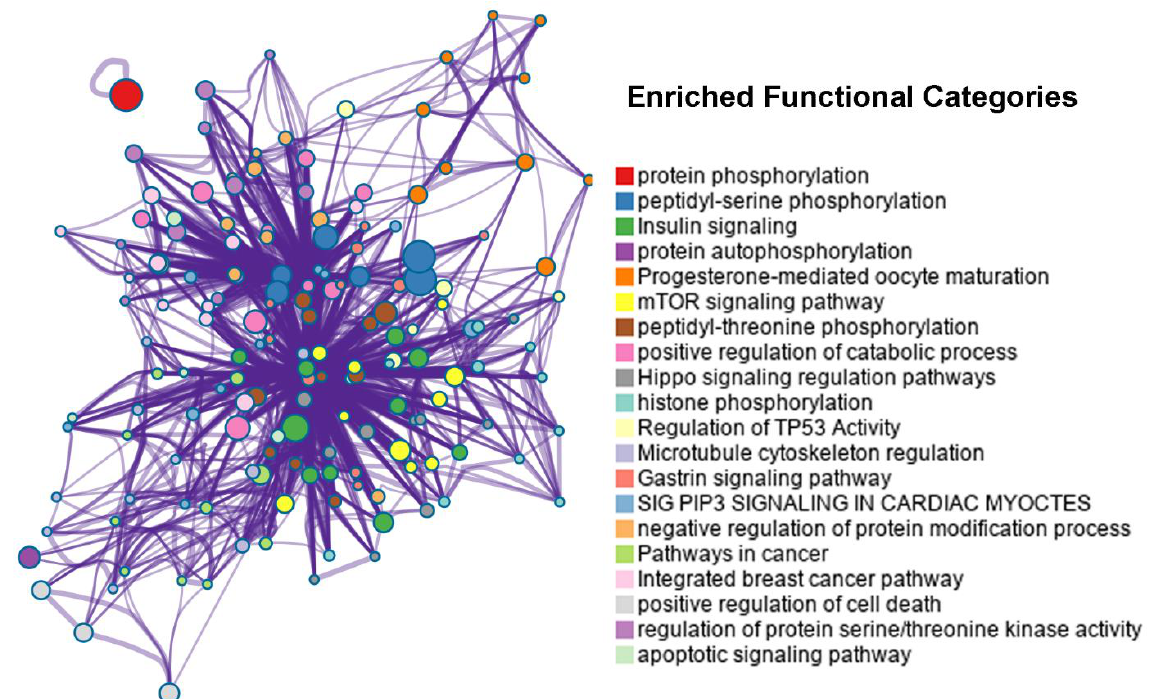
Figure 6. Network visualisation of enriched functional categories coloured by category cluster, where nodes that share the same colour are highly semantic similar to each other. Functional clusters are presented in different colours.